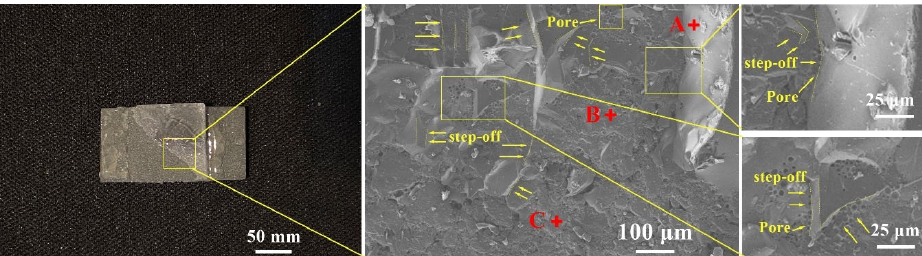
Figure 9. The fracture morphology of the joint at 540 °C for 30 min. Table 4. EDS analysis results of each point in Figure 9 (in wt.%).